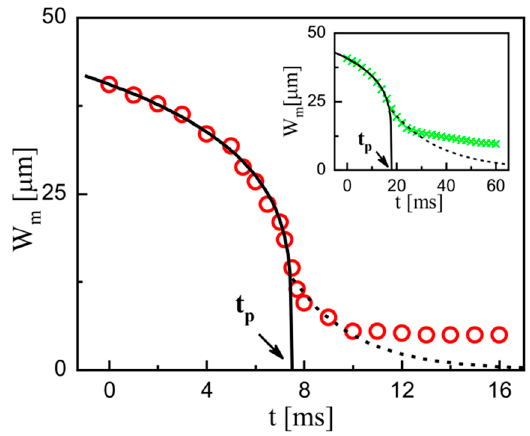
Figure 6. Typical fitting of the time-varied W m at c = 2.5 c * . The flow conditions are q = 8 and Q c = 80 μ L/h. The fitting is a combination of W m ~ ( t p − t ) α ( α = 0.24, solid curve) and W m ~ exp[ − κ ( t − t p )] ( κ = 0.39, dotted curve). The transition time t p and breakup time t b are 7.5 ms and 16 ms, respectively. Inset: The experimental data at c = 10 c * and the corresponding fit. The flow conditions are q = 4 and Q c = 40 μ L/h. t p and t b are 18 ms and 60 ms, respectively. The fitting parameters are α = 0.21 and β = 0.048.